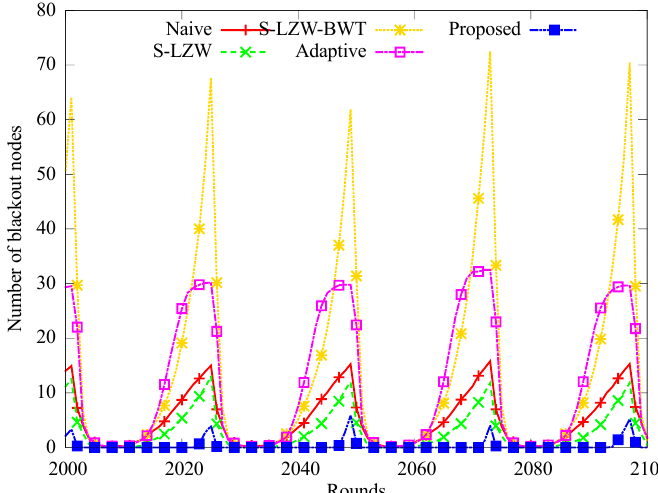
Figure 5. Change in the number of black-out nodes.